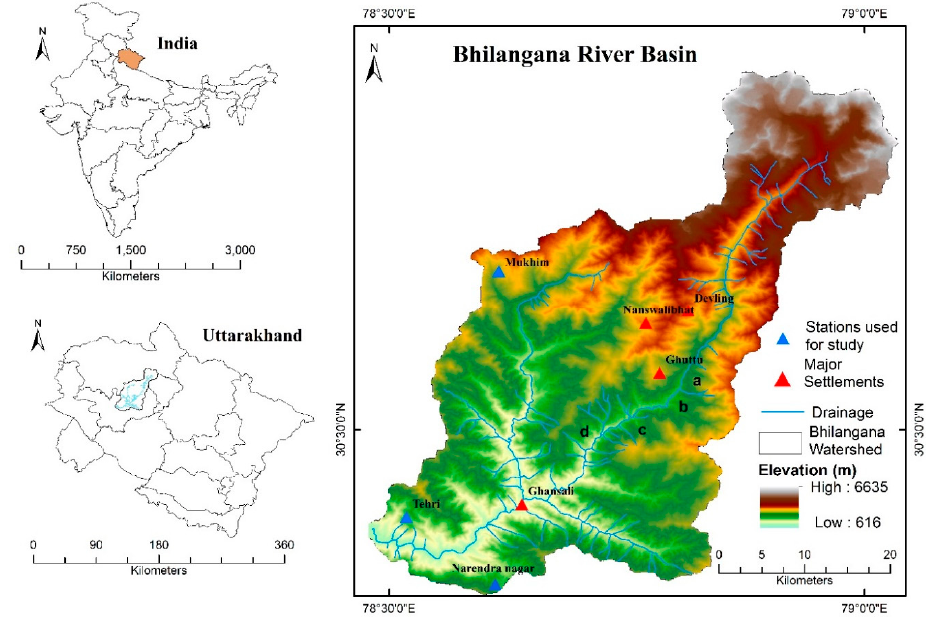
Figure 1. Location of the Bhilangana river basin in Uttarakhand, India. The IMD meteorological observatories and major settlements in the study region are indicated by blue and red solid triangles respectively. The background image is ASTER GDEMV2, derived from